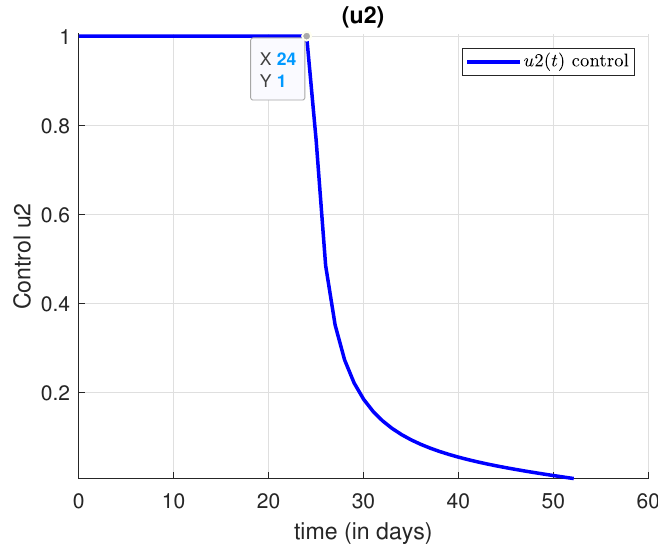
Figure 8. Evolutionary dynamics of the control u 2 ( t ) .